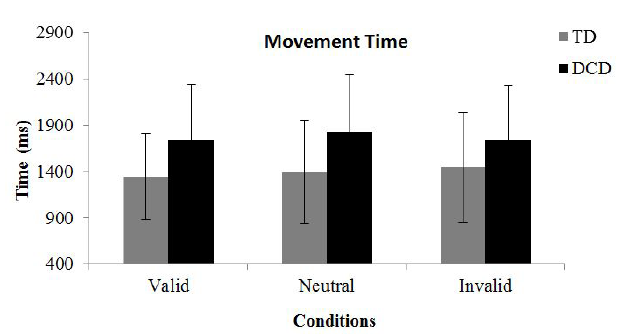
Figure 3. Movement time (ms) of children with developmental coor- dination disorder (DCD) and typically developed (TD) children under the valid, neutral, and invalid pre-cue information conditions.